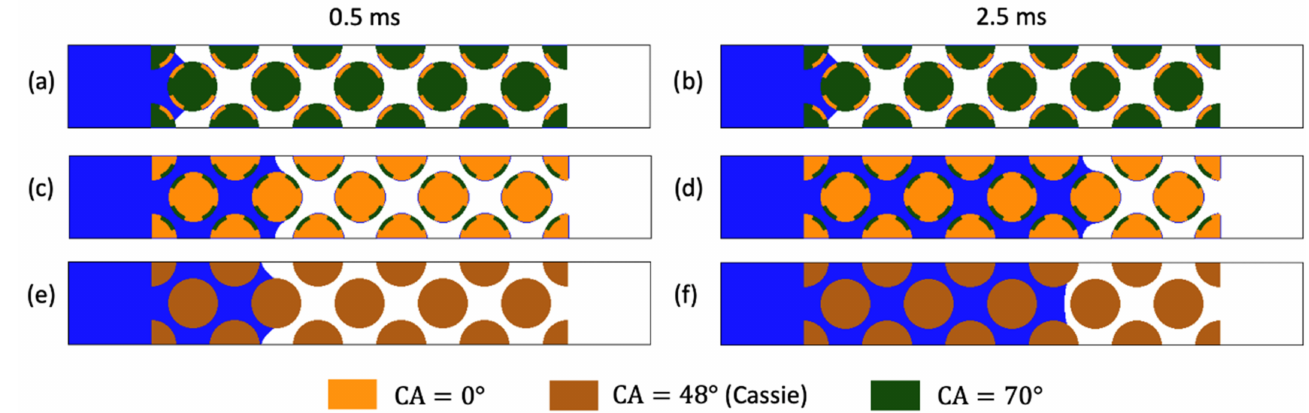
Figure 17. Infiltration for body-phobic coating with CA = 70 ◦ at ( a ) 0.5 ms, ( b ) 2.5 ms and for throat-phobic coating with CA = 70 ◦ at ( c ) 0.5 ms, ( d ) 2.5 ms as well as homogeneous coating with corresponding effective Cassie CA = 48 ◦ at ( e ) 0.5 ms and ( f ) 2.5 ms. The infiltrating water is shown in blue , while the particle surface with CA = 0 ◦ is orange, with CA = 70 ◦ is green and with effective Cassie CA = 48 ◦ is